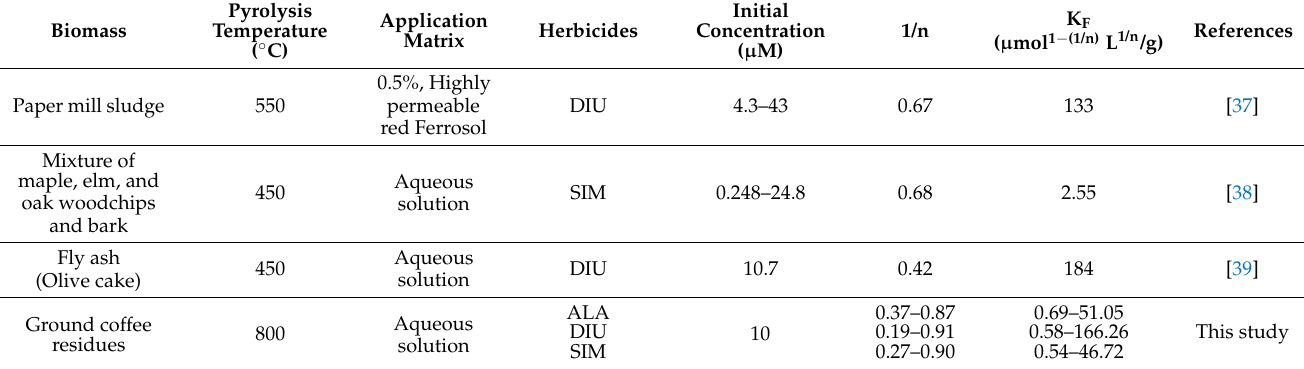
Table 5. Summary of available results related to herbicides adsorption by